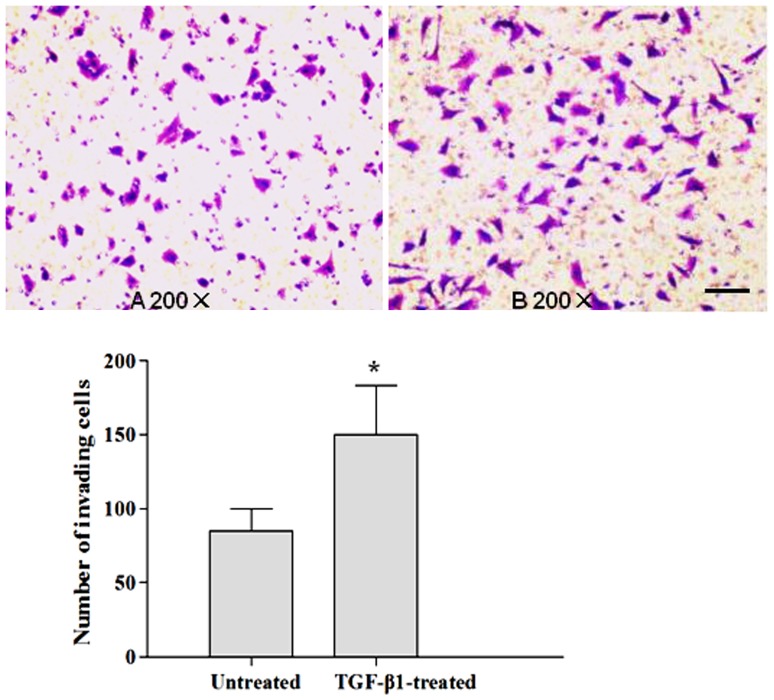
Transwell assay of Eca109 cells with or without TGF-β1 treatment.A: Untreated Eca109 cells, 200×. B: Eca109 cells treated with TGF-β1 (10 ng/mL) for 24 h, 200×. C: The number of invading cells: Untreated Eca109 cells vs. Eca109 cells treated with TGFβ1. Data shown represent the average of 3 independent experiments. *p <0.001, compared with untreated cells. All experiments were performed at least 3 times in triplicate. Scale bars represent 100 µm.